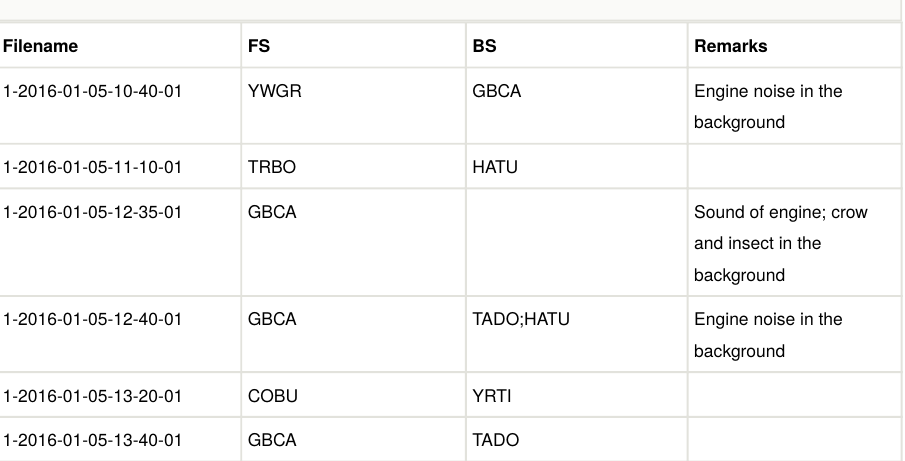
Annotation of audio recordings obtained at the DeKUWC (FS= Foreground Species, BS= Background